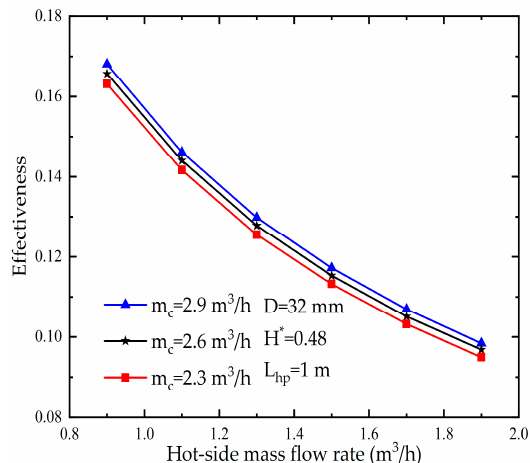
Figure 8. Comparison of effectiveness with different cold side mass flow rates.